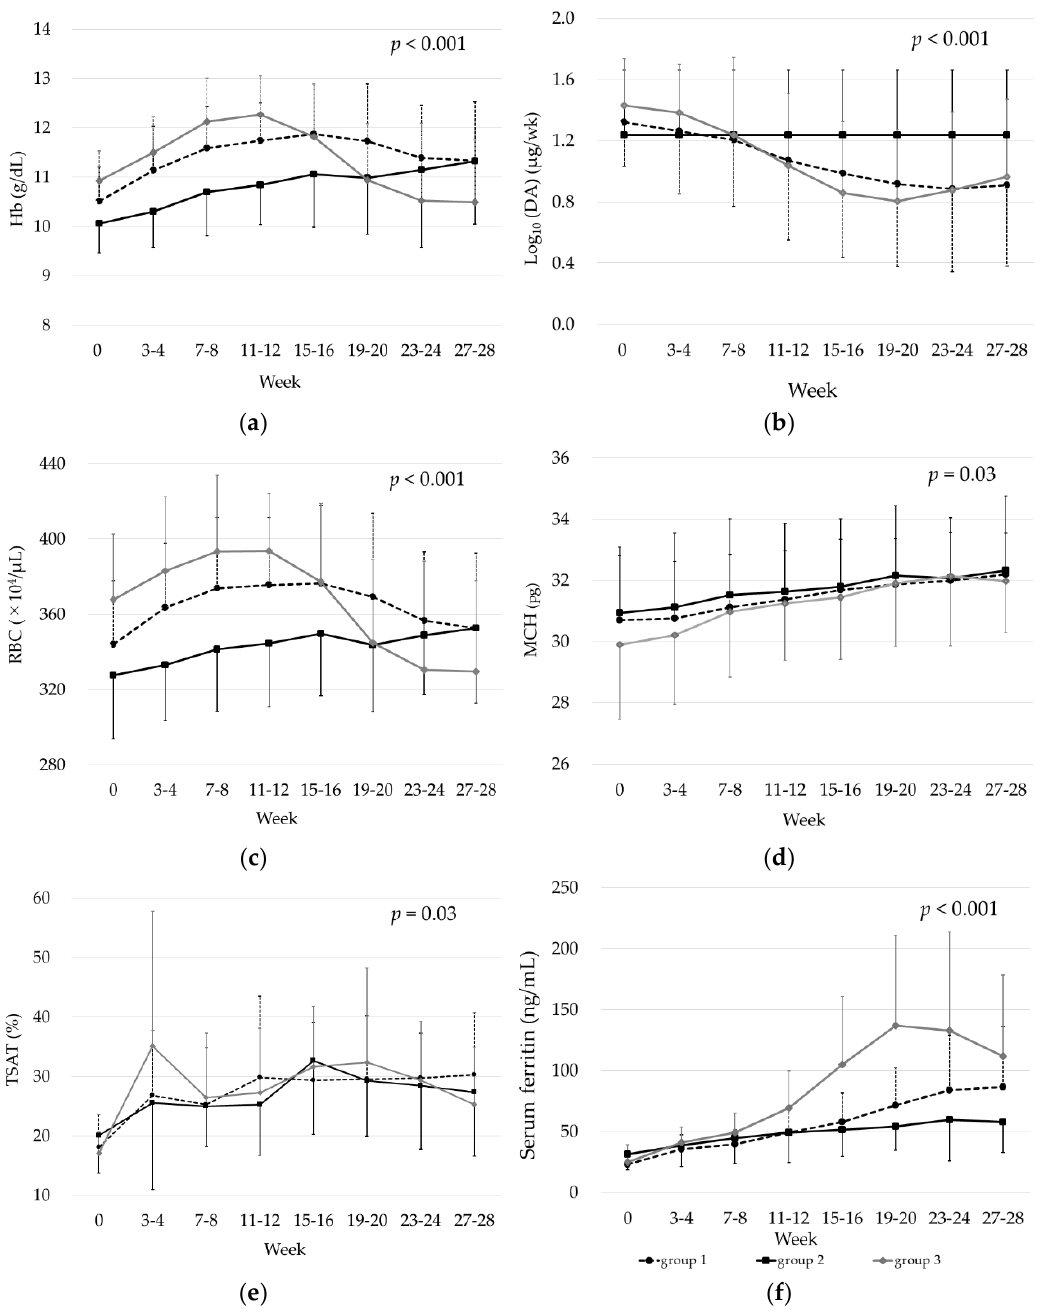
Figure 3. Two-way repeated-measures analysis of variance was used for comparison among Groups 1–3. ( a ) Hemoglobin (Hb), ( b ) Log10 (DA), ( c ) red blood cells (RBC), ( d ) mean corpuscular hemoglobin (MCH), ( e ) transferrin saturation (TSAT), ( f ) serum ferritin.